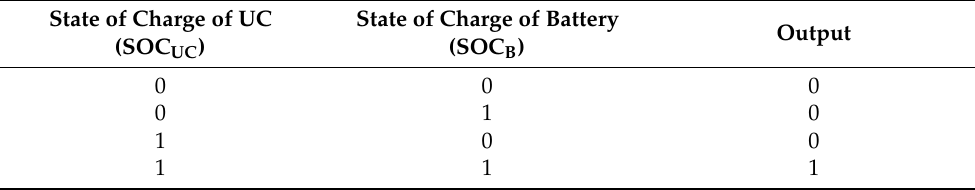
Table 6. Truth Table for EMS Algo